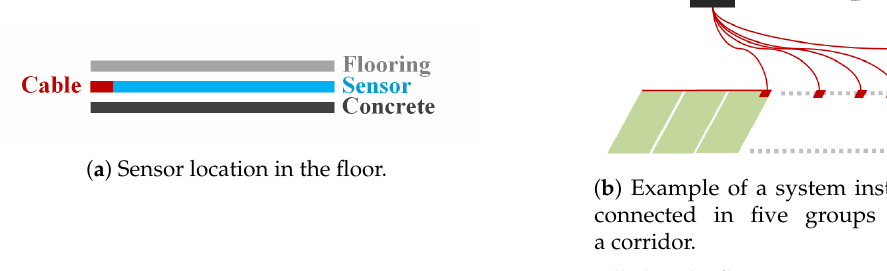
Figure 1. Pressure sensor installed in the